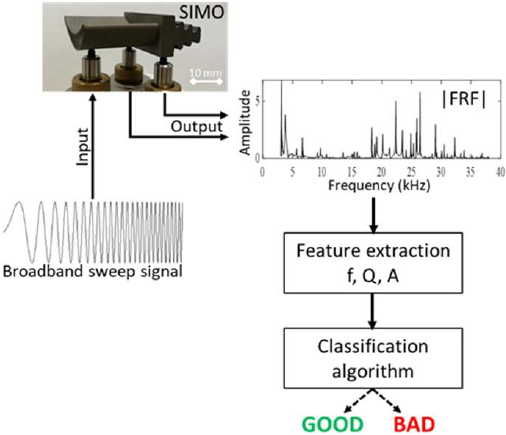
Figure 4. A schematic of the measurement procedure (reproduced with permission from Elsevier) [16].